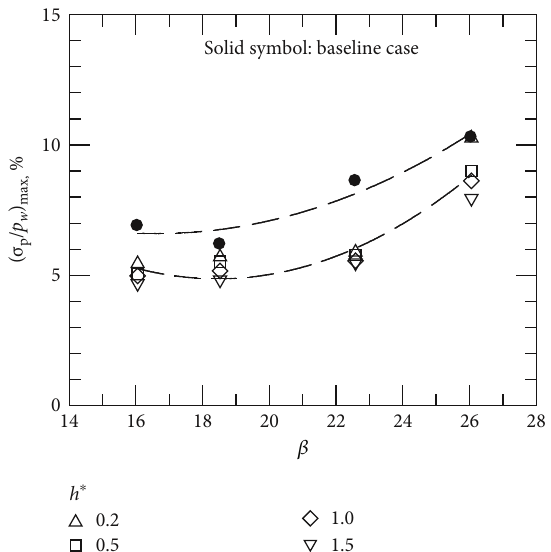
Figure 7: Distribution of surface pressure fl uctuations for M = 0 : 83